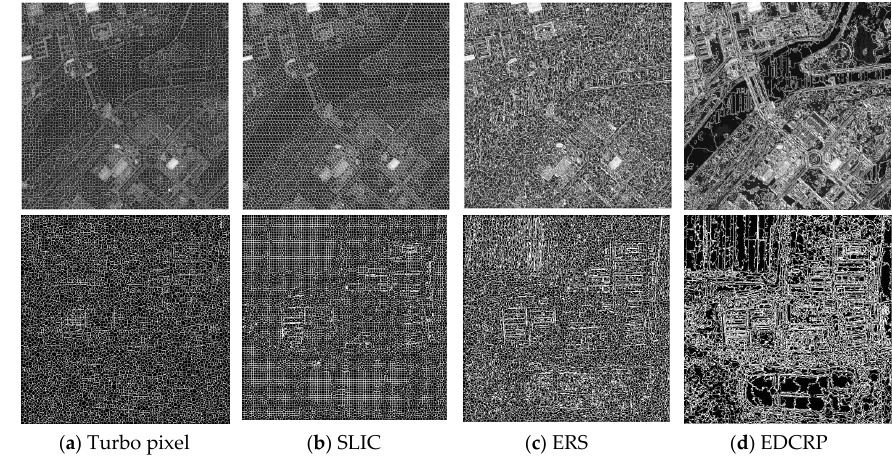
Figure 10. The over-segmentation results over both TIANHUI (first row) and QUICKBIRD (second row) images using four over-segmentation methods, i.e., ( a ) Turbo pixel, ( b ) Simple Linear Iterative Clustering (SLIC), ( c ) Entropy Rate Superpixel segmentation (ERS), and ( d ) Edge Dependent Chinese Restaurant Process (EDCRP).